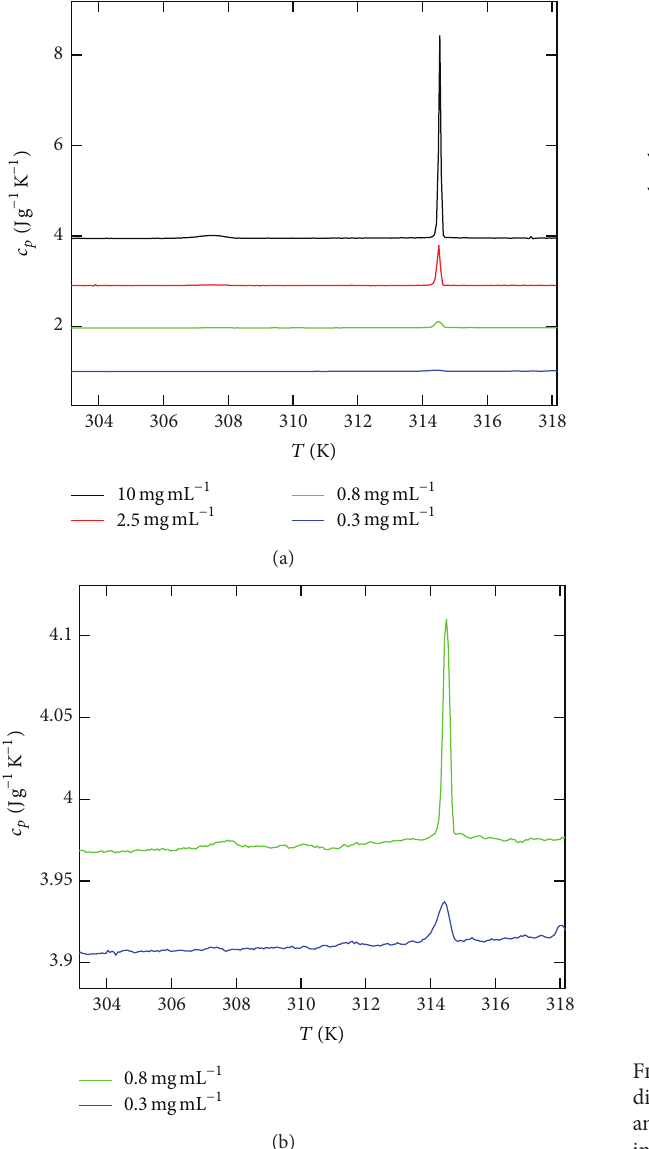
Figure 3: (a) Specific heat capacity 𝑐 𝑝 (𝑇) of a 10mg mL −1 DPPC vesicle suspension and of three subsequent dilutions as measured with pASC. The curves have been shifted vertically for display reasons and show the total suspension 𝑐 𝑝 , not that of the lipid alone. (b) An enlarged view on the most diluted samples.